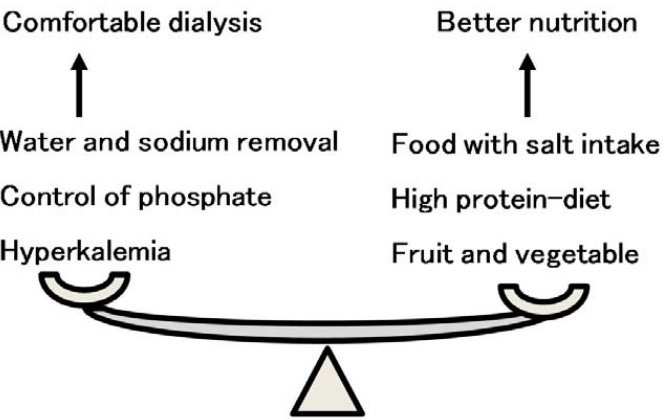
Figure 10. The balance of food and salt intake between comfortable dialysis and better nutrition. Comfortable dialysis therapy is sometimes contrary to better nutritional intake. Sufficient food intake with proper salt taste increases intradialytic body weight gain, resulting in prolonged dialysis session time. A high-protein diet easily induces hyperphosphatemia, resulting in vascular calcification and cardiovascular events. Healthy fruit and vegetable intake induces Table 1. Standard nutritional intake in hemodialysis patients in Japan.